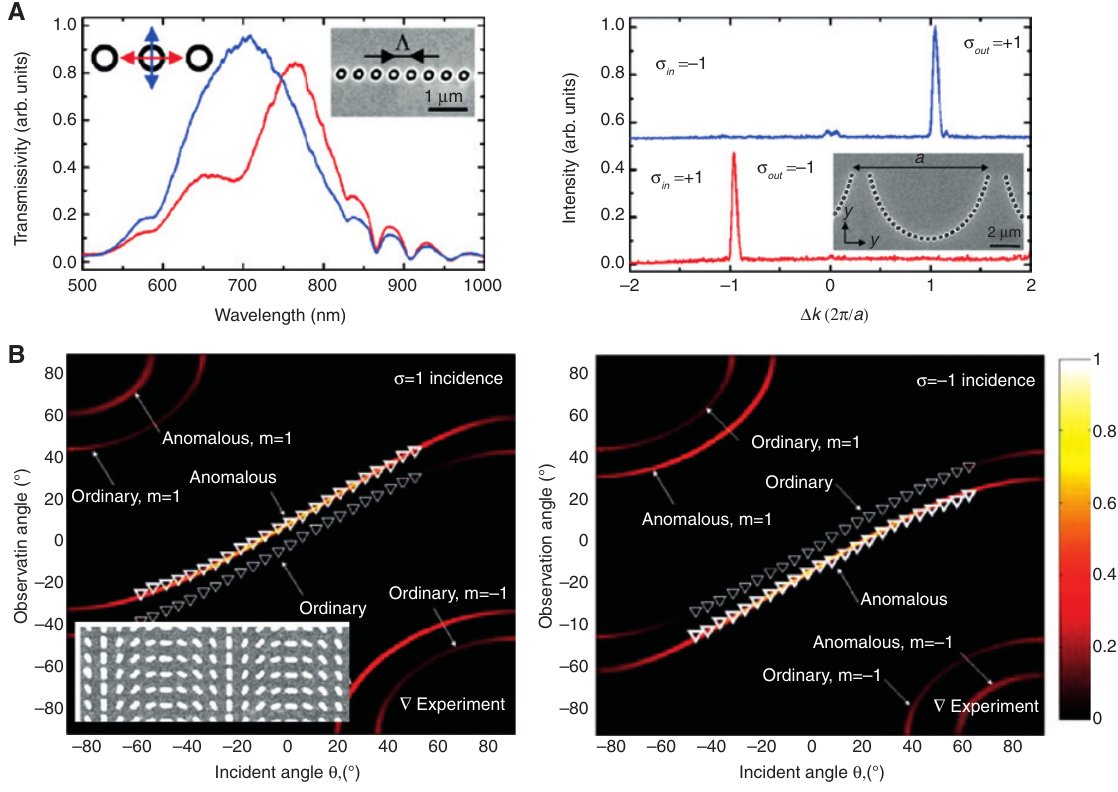
Figure 3: Spin splitting in linear momentum space. (A) Isotropic coaxial nanoapertures chain for SHE. Left: Transmission spectra of the plasmonic chain showing anisotropy for linear polariza- tion along two orthogonal directions due to the coupling of neighboring particles. Right: Spin-dependent momentum redirection for the OSHE. Inset: SEM image of a curved chain. Reproduced from Ref. [53]. (B) Anisotropic nanorod array for OSHE. Left (Right): Measured reflec- tion angle versus incident angle for σ = 1 ( σ = −1) incidence, respectively. Inset: SEM image of nanorods fabricated on an ITO-coated glass. Reproduced from Ref.